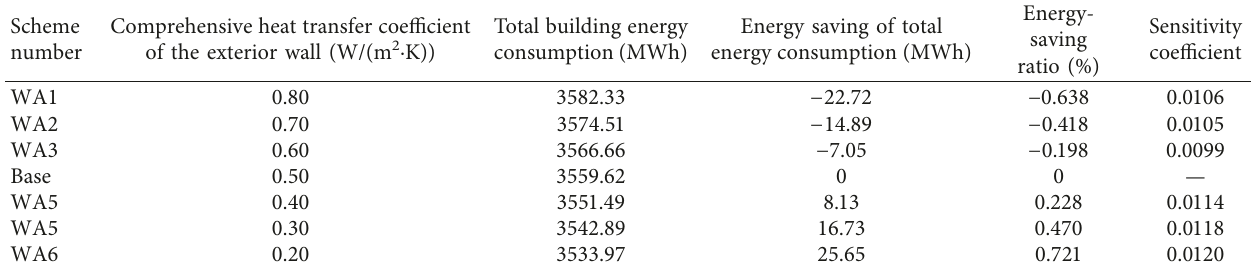
Table 5: Sensitivity of the external wall heat transfer coefficient to the total building energy consumption. Scheme Comprehensive heat transfer coefficient number of the exterior wall (W/(m 2 · K))